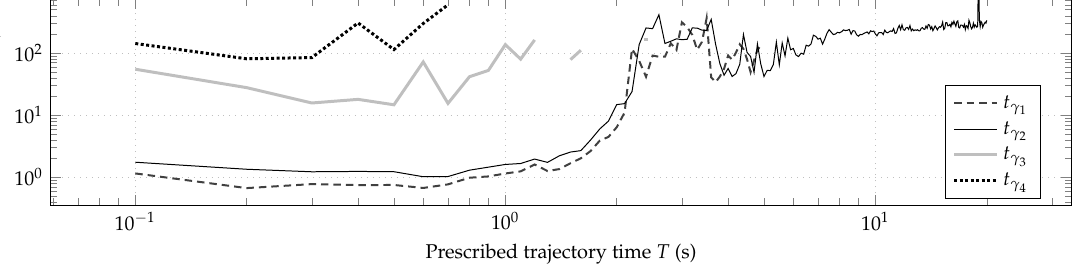
( d ) Zoom-in: RMS power evolution for the upward motion